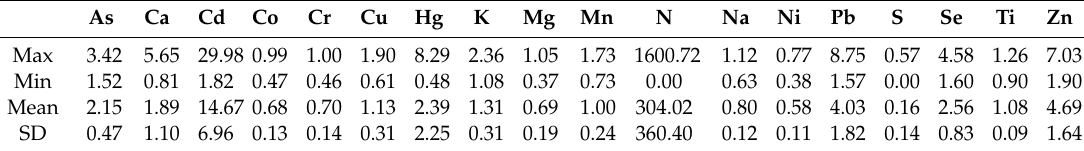
Table 2. Enrichment factor (EF) in atmospheric deposition in the Gannan County